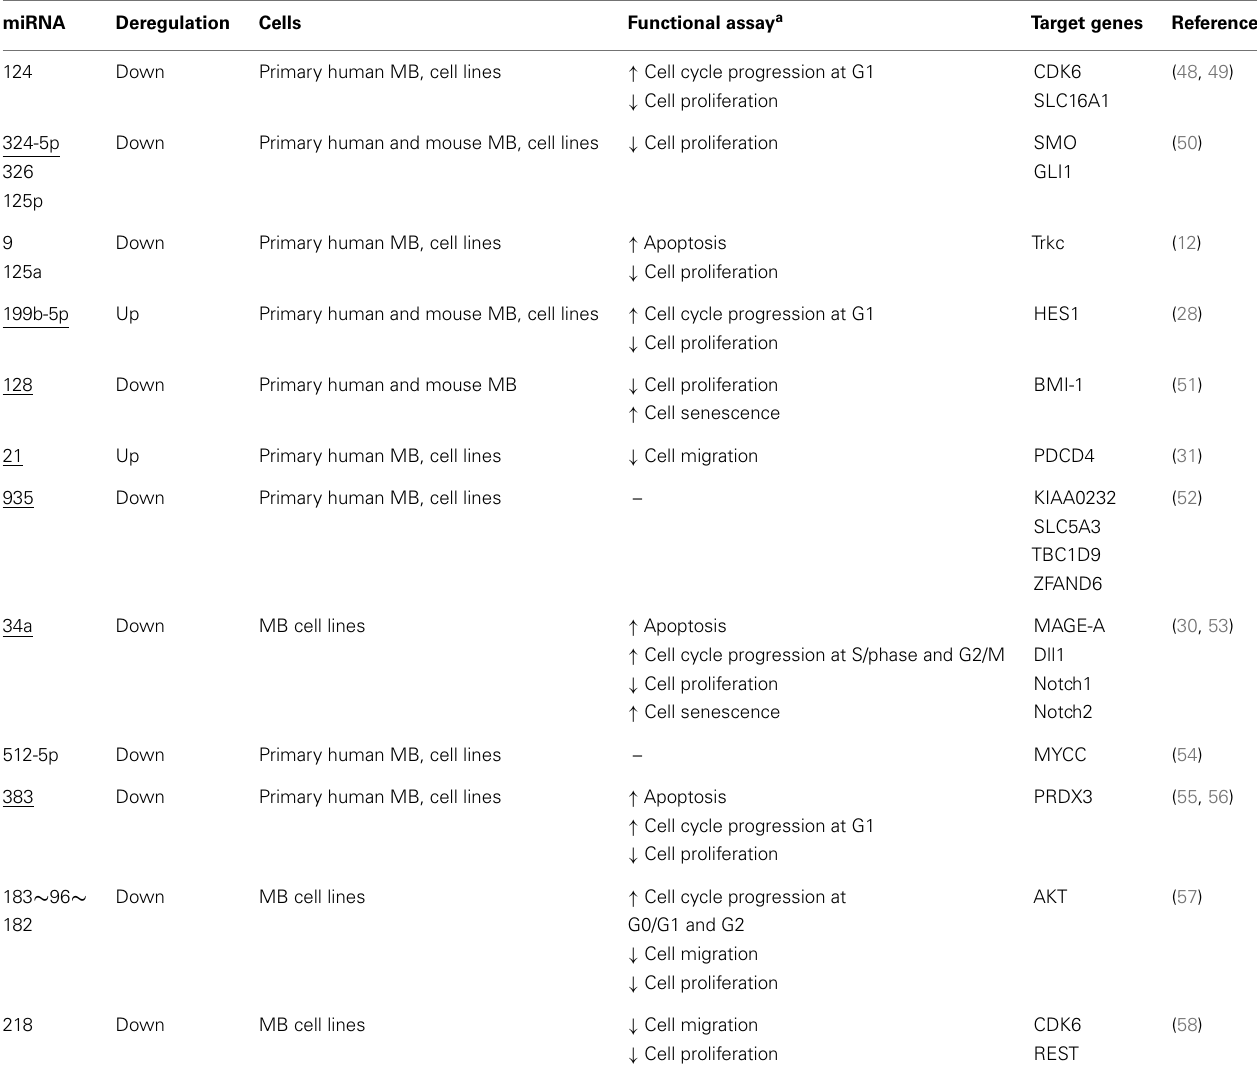
Table 4 | miRNAs validated by functional assay in human and mouse